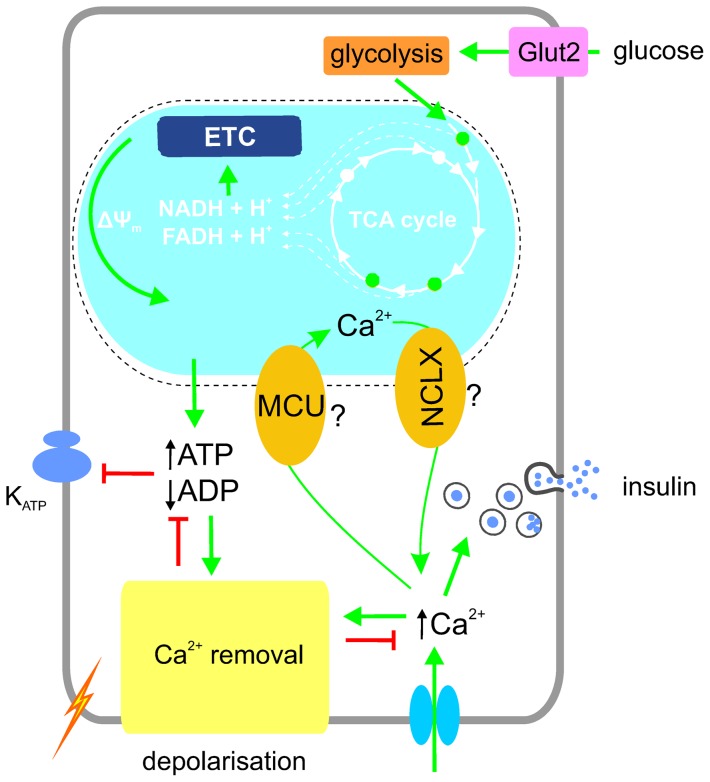
Proposed scheme of interplay between Ca2+, ATP and Vm in the β-cell.The oxidation of glucose that enters the β-cell hyperpolarises the mitochondrial membrane (ΔΨm) thereby leading to the elevation of cytosolic ATP/ADP ratio, closing of KATP channels, depolarisation of the plasma membrane (Vm) and Ca2+ entry. Elevated cytosolic [Ca2+] triggers a number of ATP-dependent processes including insulin secretion and Ca2+ removal into the ER and extracellular medium. By entering mitochondria via MCU, Ca2+ potentiates oxidative metabolism to counter-balance ATP expenditure. Ca2+ exits mitochondria via NCLX.